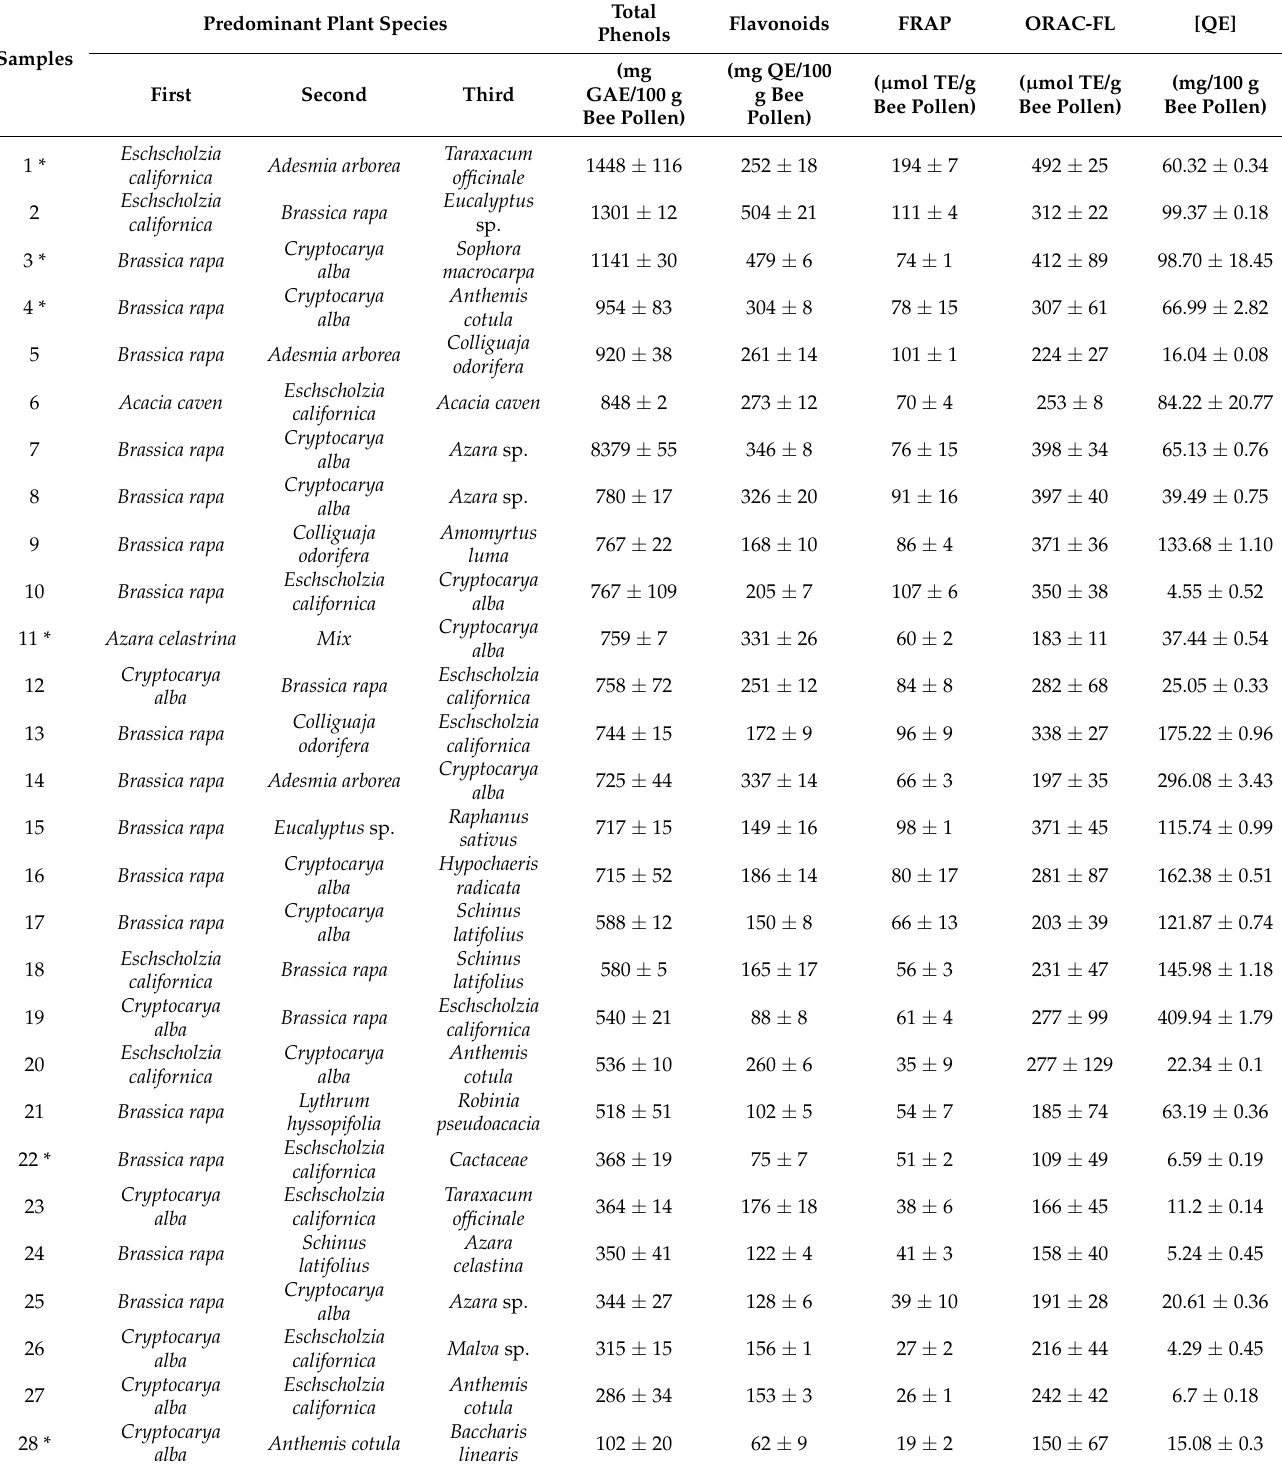
Table 1. Average values of total phenols (TP), flavonoids, FRAP, ORAC-FL, and quercetin (QE) concentration in bee pollen extracts from the V region of Chile collected in